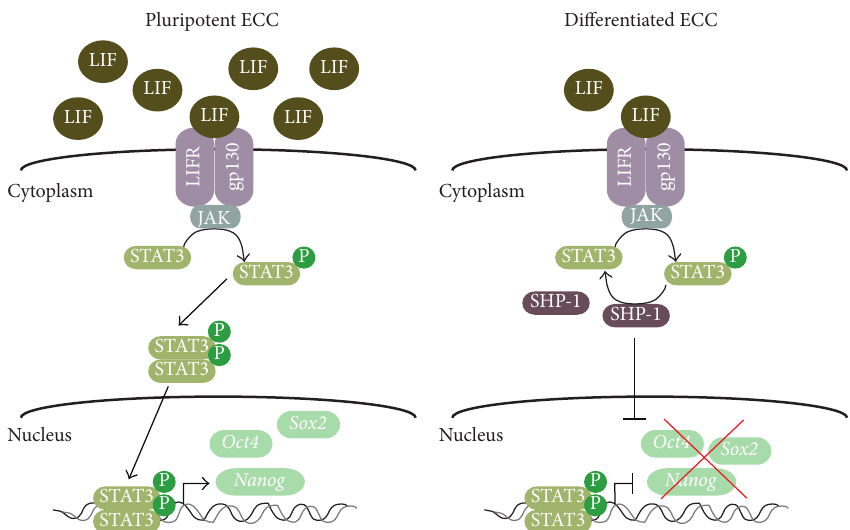
Figure 1: LIF signaling maintains ECCs pluripotency. In pluripotent ECC lines, LIF binds to the LIF receptor (LIFR) and gp130 recruiting Janus Kinase (JAK), which in turn phosphorylates and activates Signal Transducer and Activator of Transcription 3 (STAT3). Phosphorylated STAT3 homodimerizes and translocates to the nucleus promoting the expression of pluripotency genes encoding OCT4, SOX2, and NANOG. During differentiation, LIF levels decline substantially leading to decreased phosphorylated STAT3, which is augmented by the tyrosine- specific protein phosphatase SHP-1. The decline in active STAT3 reduces the expression of pluripotency